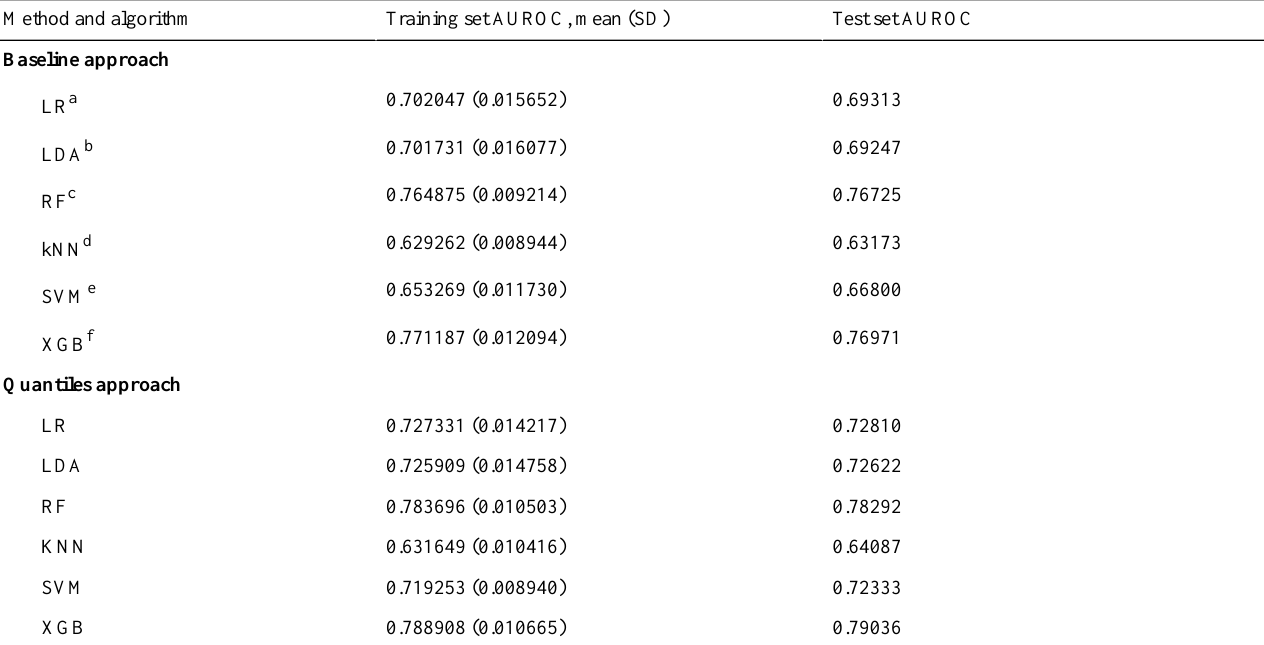
Table 9. Mortality model performance based on area under the receiver operating characteristic curve